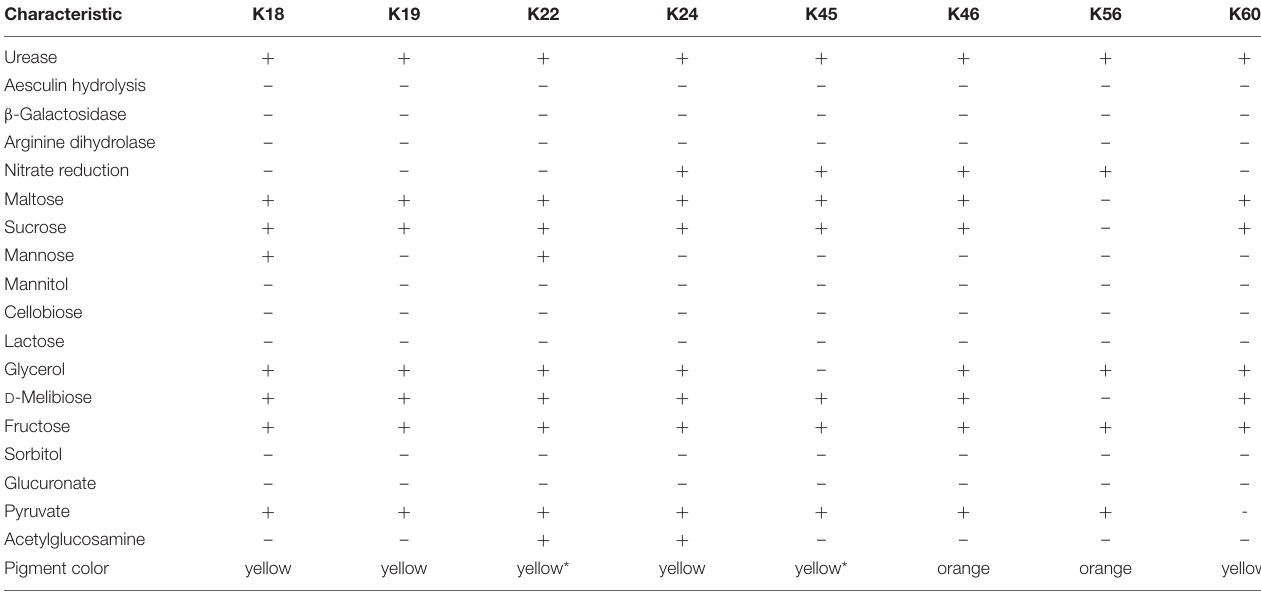
TABLE 1 | Biochemical characteristics of eight Kocuria